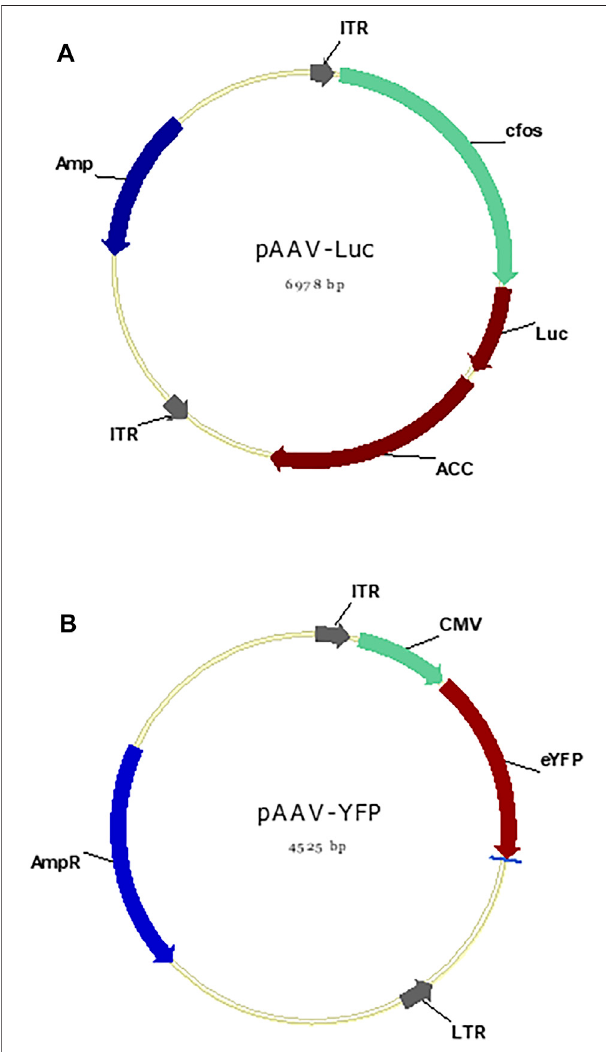
FIGURE 3 | Effect of transfection reagent, operation mode and host cell. The three-plasmid (pAAV, pHelper, and pAAV-DJ/8 Rep-Cap) transfection was used to produce AAV. (A) Adherent AAV production mediated with three transfection reagents including calcium, lipofectamineandliposomes.TheHEK293AAVcellswerecultivatedin30-ml high-glucose DMEM medium supplemented with 10% FBS, 0.1 mM MEM NEAA, 2 mM L-glutamine and 1% Pen-Strep in petri dish (data represent mean ± SEM, n = 4). (B) Effect of host cells on AAV production in adherent cultures ( n = 2). Three host cells, i.e. HEK 293AAV, 293A, and 293F, were tested with calcium transfection. (C) Suspensive AAV production mediated withthreetransfectionreagentsincludingPEI,TurboFectandliposomes.The HEK 293F cells were cultivated in 30-ml chemical de fi ned FreeStyle medium supplemented with 4 mM GlutaMAX at agitation speed of 135 rpm ( n = 4). ** p ≤